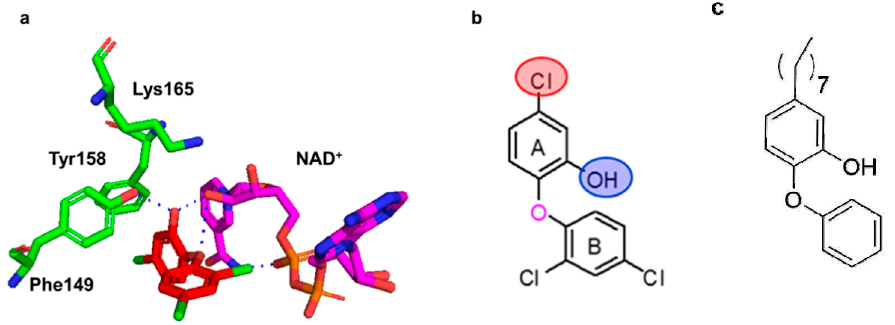
Figure 1. ( a ) Representation of TCS (red) bound to the active site of InhA. (Active site residues (green) and NAD + (magenta) (derived from PDB.2B35). ( b ) The constituents of the TCS structure important for activity as identified by Sivaraman et al. [26] are highlighted. ( c ) Structure of inhibitor 8PP.